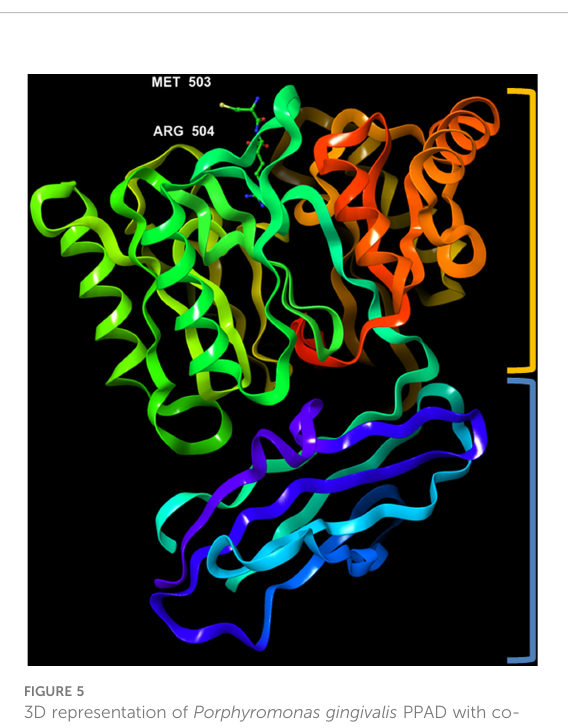
FIGURE 5 3D representation of Porphyromonas gingivalis PPAD with co- crystallized ligand, Met-Arg dipeptide (substrate complex) (PDB ID: 4YTG). Highlighted in orange: crown (catalytic domain), blue: root (IgSF